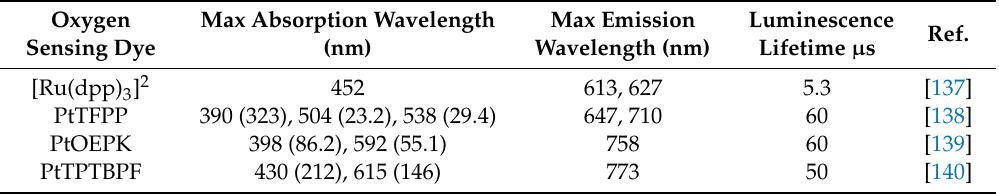
Table 3. Photophysical properties of commonly used oxygen dyes in oxygen sensing.